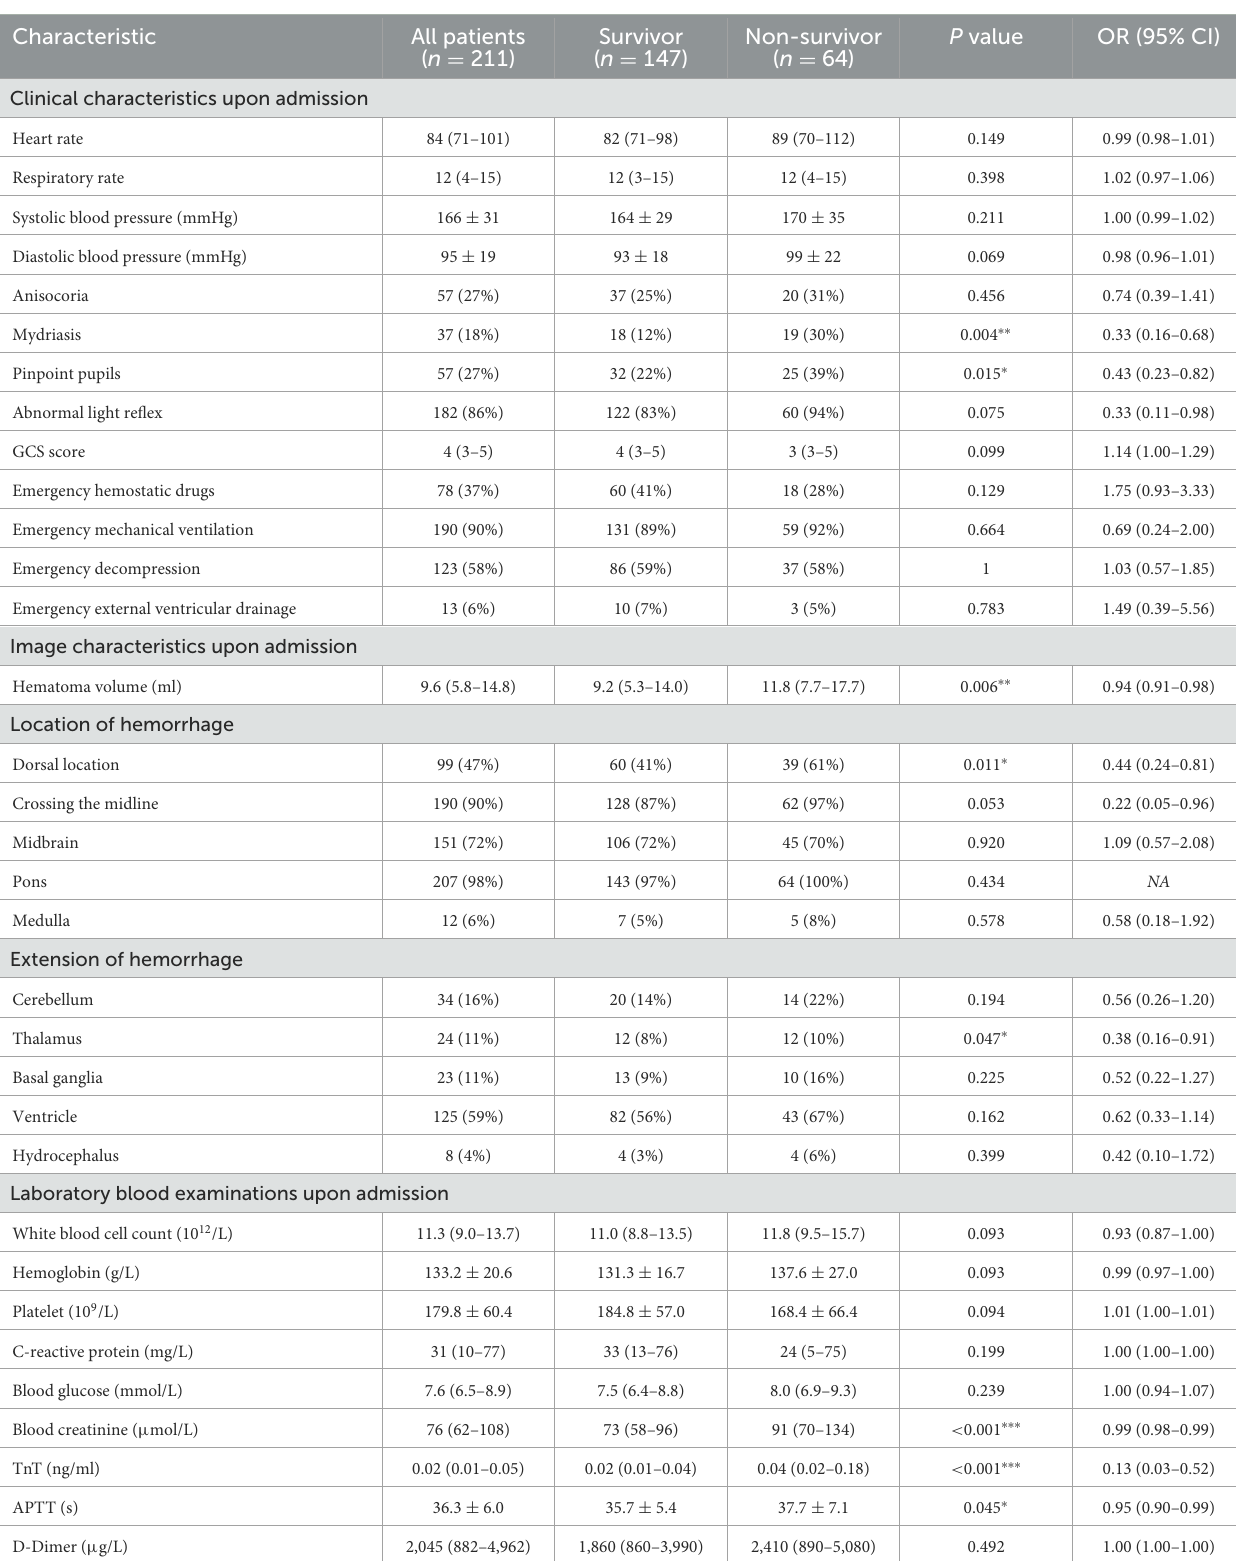
TABLE 2 Associations of characteristics upon admission with 30-day